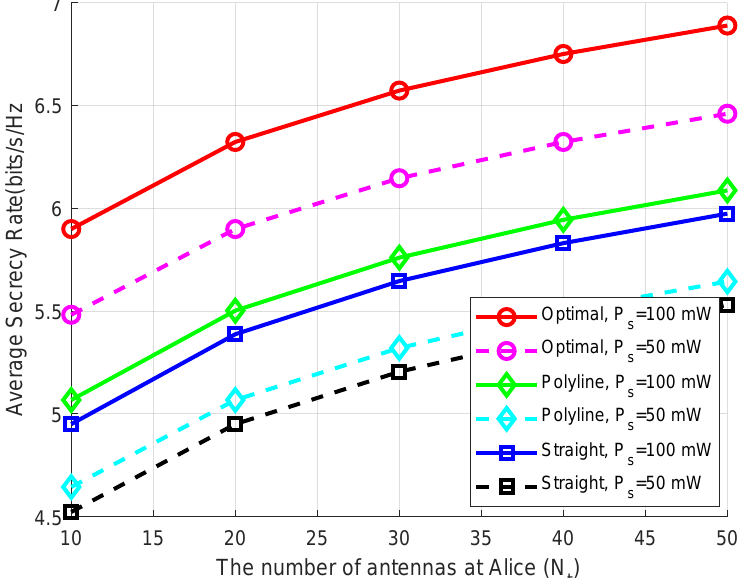
Figure 6. The average secrecy rate performance relative to the number of antennas at Alice, where the transmit power is set to P s = [ 50,100 ] mW.